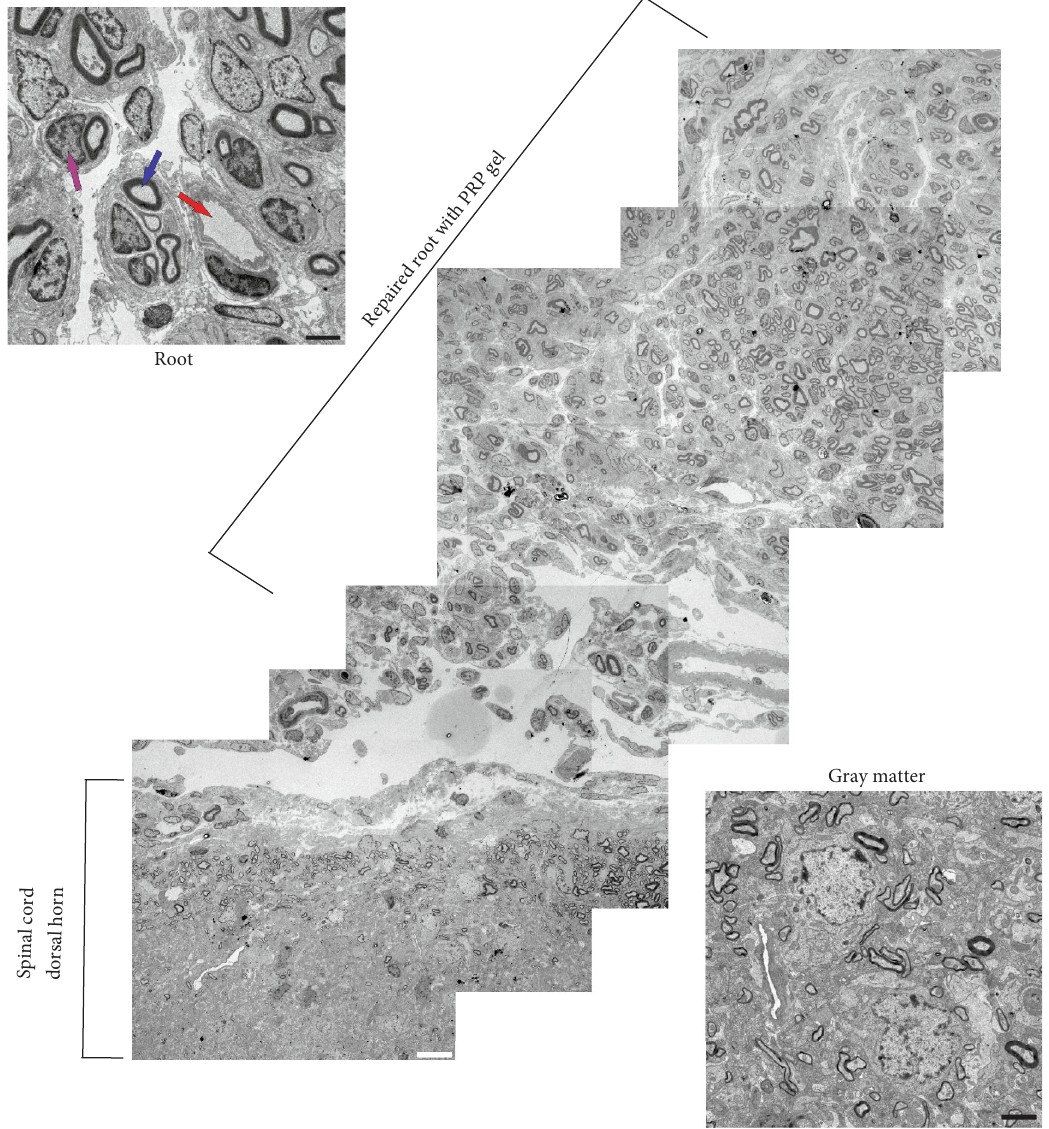
Figure 7: Representative transmission electronic micrographs of the repaired root and spinal cord dorsal horn (super fi cial region), 8 weeks after dorsal rhizotomy (DRZ) and repair with PRP gel. The extent of the repaired root can be observed with a signi fi cant number of myelinated axons (blue arrow), blood vessels (red arrow), and many Schwann cells (purple arrow). The image also highlights the subtle boundary between PNS/CNS clearly delimited by the dorsal root transition zone (DREZ), which contains central and peripheral nervous tissue. Moreover, proximal to the DREZ, myelin sheaths formed by oligodendrocytes can be observed, while further from the DREZ, the sheaths are formed by Schwann cells and wrapped the endoneurium. Their presence on the spinal surface of the root repaired in these morphological and structural conditions is one of the requirements for functional